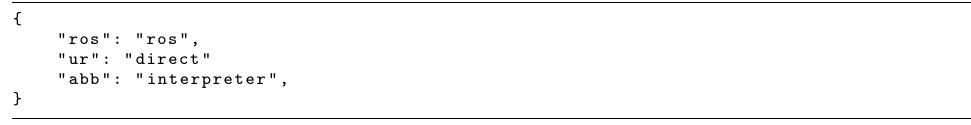
Figure A1. Profile configuration